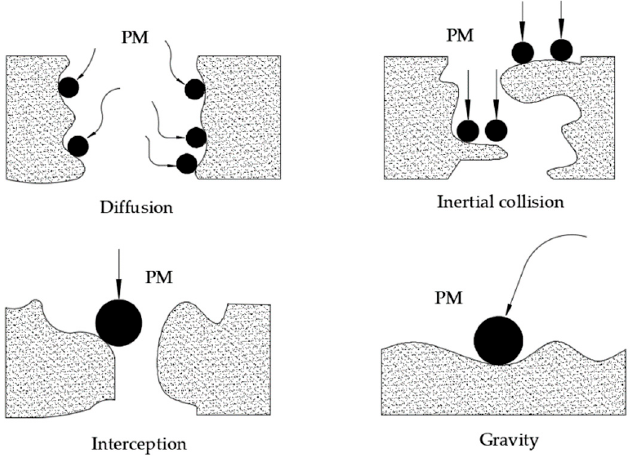
Figure 2. Filtration mechanism of particulate filters.